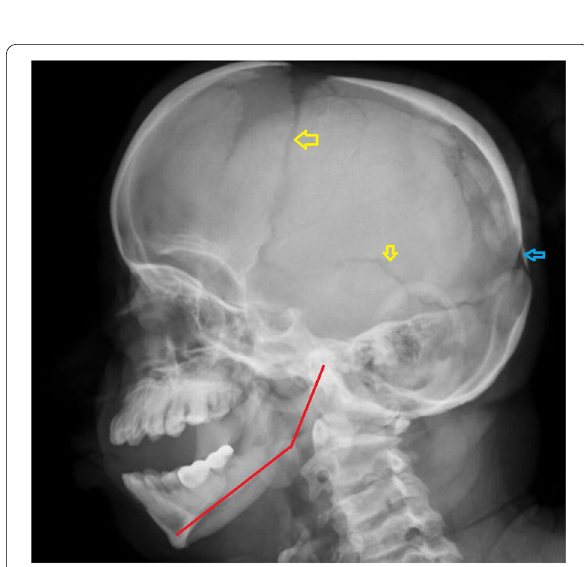
Fig. 5 Lateral radiograph of the skull showing open sutural lines (yellow lines), the presence of Wormian bone (blue line) and obtuse mandibular gonial angle (red